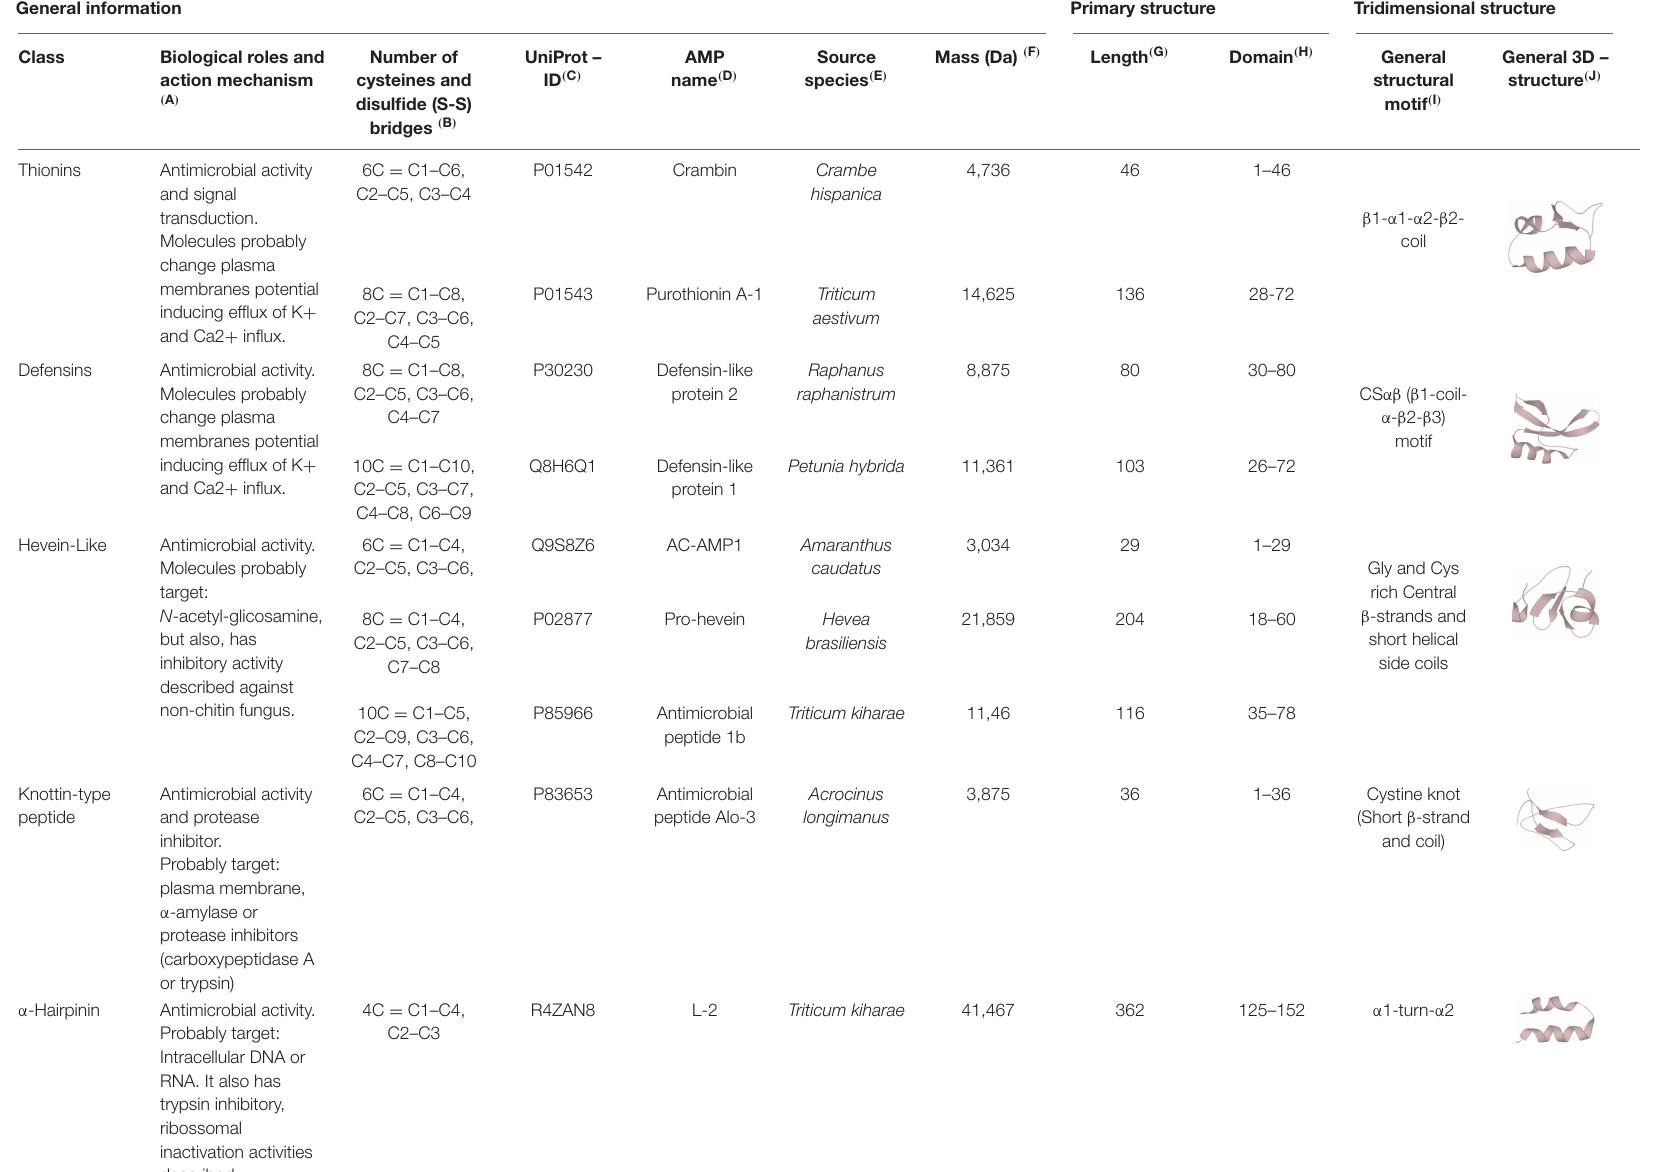
TABLE 2 | Main classes and features of plant antimicrobial